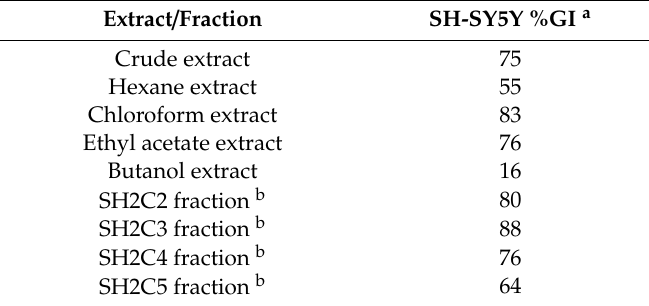
Table 3. Antiproliferative E ff ect of Simarouba Extract / Fraction on Neuroblastoma SH-SY5Y Cancer Cell